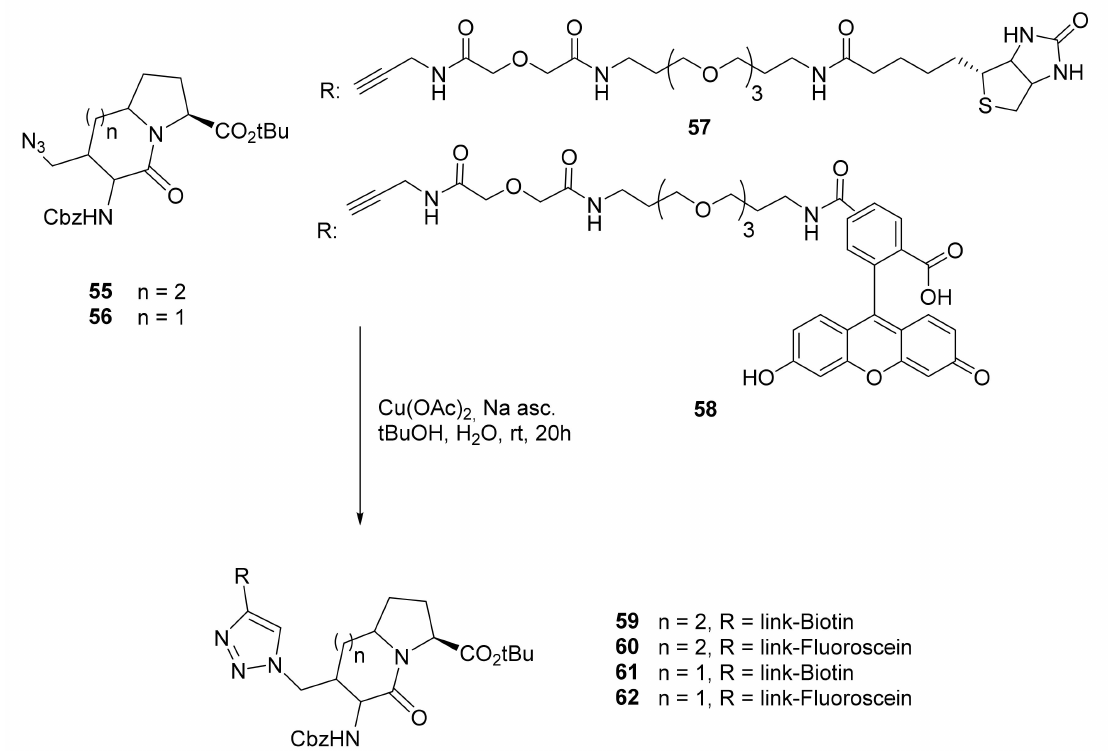
Scheme 7. Cycloaddition between pseudopeptides 55 and 56 and conjugated biotin and